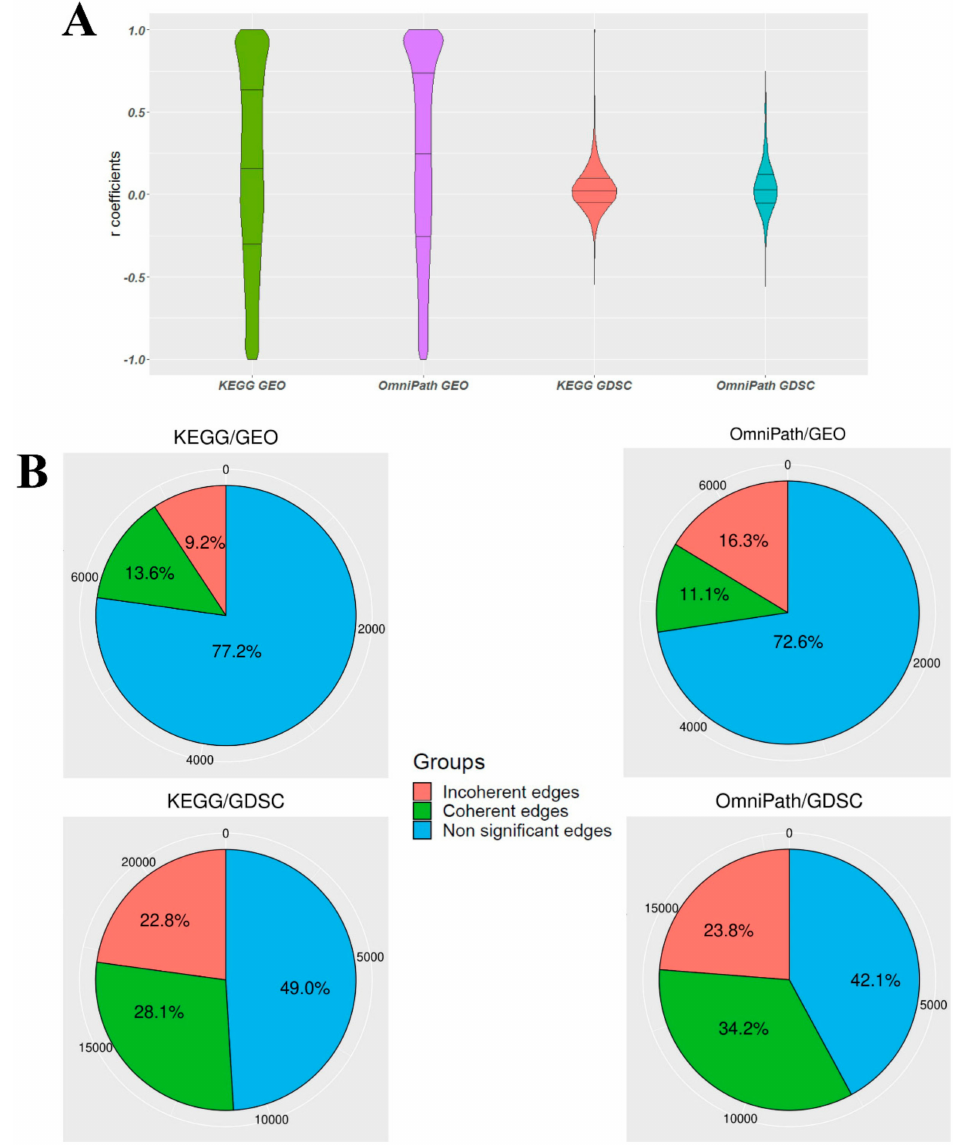
Figure 3. ( A ) Distribution of Pearson correlation coe ffi cient values for the four parallel coherency analyses. ( B ) The ratio of coherent and incoherent edges in addition to the ratio of non-significant edges that have adjusted p -values of correlation test larger than 0.05. The values around each pie chart represent the exact